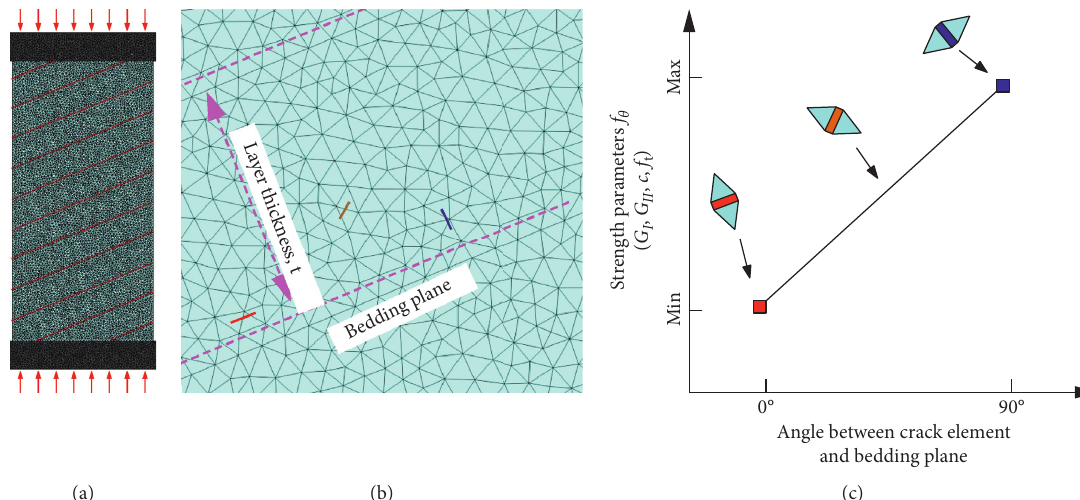
Figure 9: Numerical simulation model. (a) Uniaxial compression model. (b) Partial enlarged view of the model. (c) Linear variation of strength parameters with the angle between crack element and bedding plane.